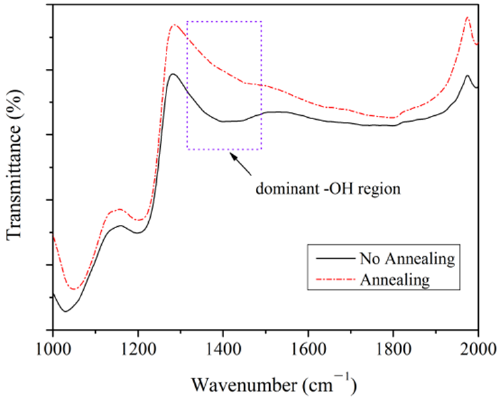
Figure 9. Comparison of the infrared spectra of the graphene monolayer on the substrate with and without annealing.